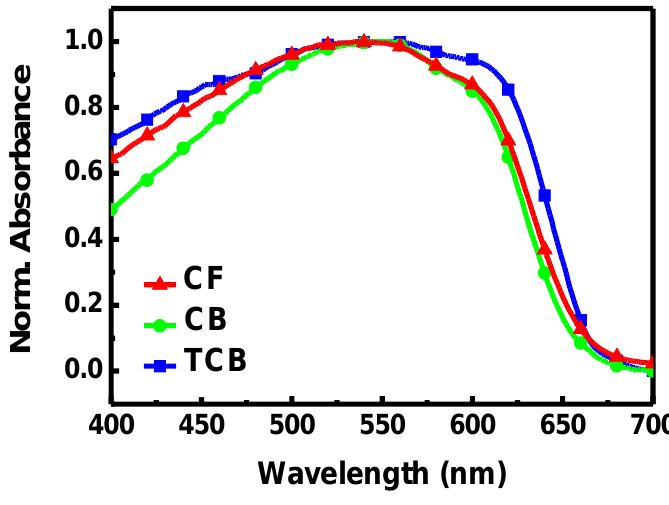
Figure 5. Optical absorption spectra of P3HT electrospun nanofibers prepared from three different solvent systems.